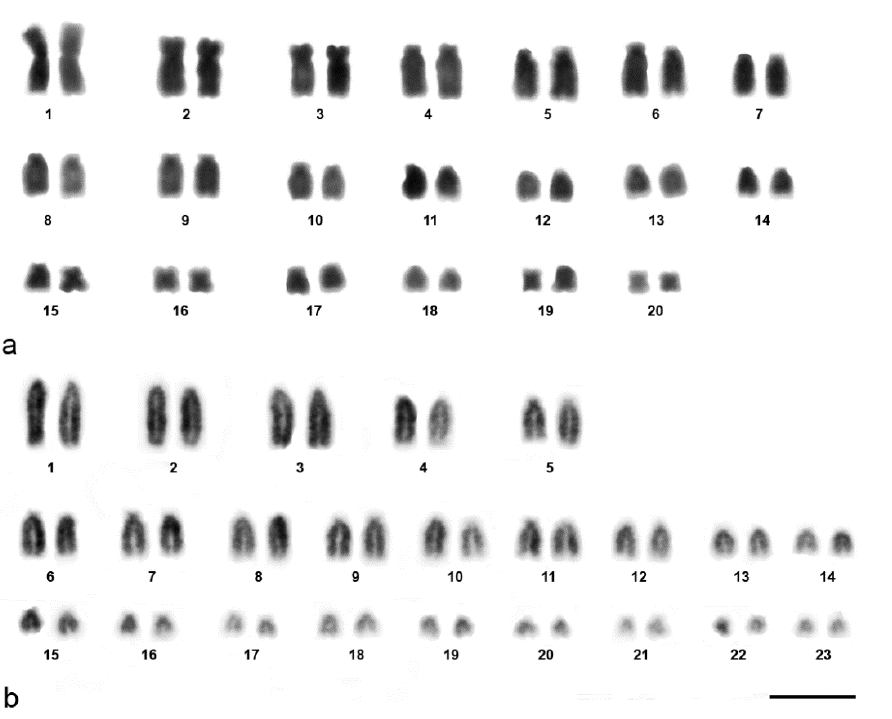
Figure 1. Gray images of DAPI-stained karyotypes of the common house gecko ( Hemidactylus frenatus , Duméril and Bibron, 1836) [72] ( a ) and the flat-tailed house gecko ( Hemidactylus platyurus , Schneider, 1797) [73] ( b ). Scale bar represents 10 μ m.